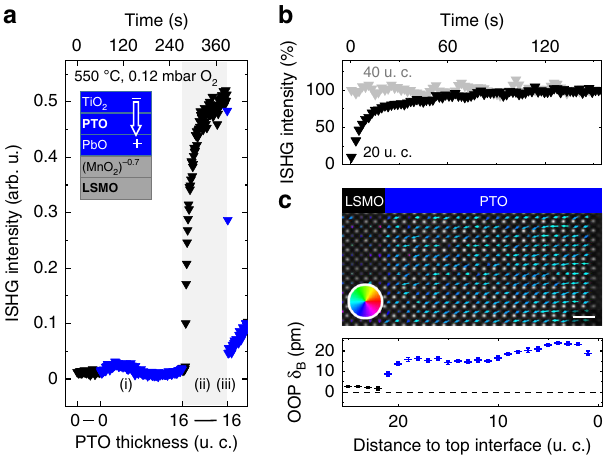
Fig. 2 Polarization enhancement from cooperative interfaces. a ISHG signal during ongoing ( fi lled blue symbols, 0 – 16 u. c.) and halted ( fi lled black symbols) growth. The inset shows the chemistries of interfacial planes at the PTO ∣ LSMO interface and the polarization direction set by the bottom interface. b Time-dependent ISHG signal after interrupting deposition, normalized to the maximum value = 100. c Post-deposition STEM map of the dipole moments. The arrows show the direction (color wheel) and amplitude (arrow length) of the dipole moments (top). Scale bar is 1 nm. The OOP B-site displacement ( δ B ) of the persistent state is mapped throughout the PTO ∣ LSMO bilayer (bottom). Black symbols refer to LSMO, and blue symbols refer to downwards polarization in PTO. The error bars are the standard error of the